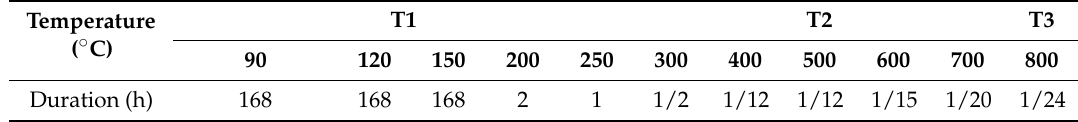
Table 3. The temperature and duration of simulated thermal tests.